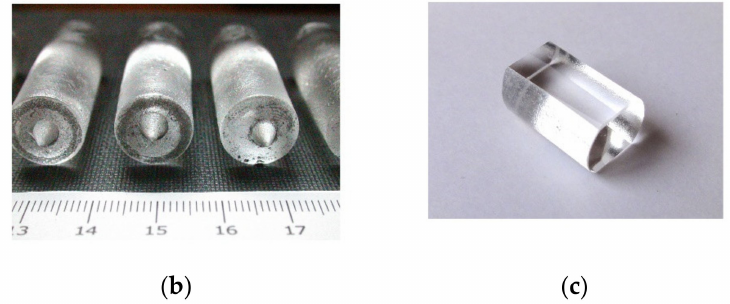
Figure 4. Appearance of the grown Ca 1– x Y x F 2+ x crystals: top ( a ) and side ( b ) view; fabricated Ca 0.9 Y 0.1 F 2.1 optical element ( c